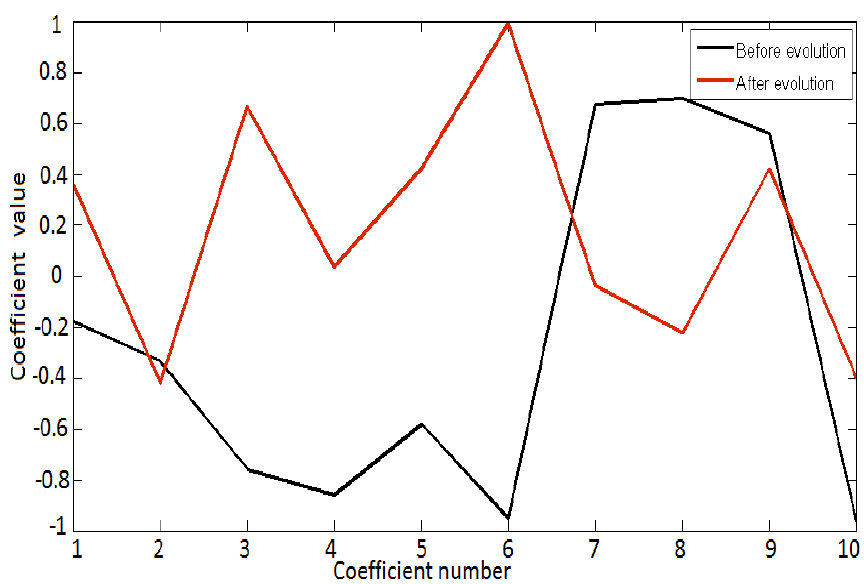
Figure 3. Pseudo-wavelet before and after